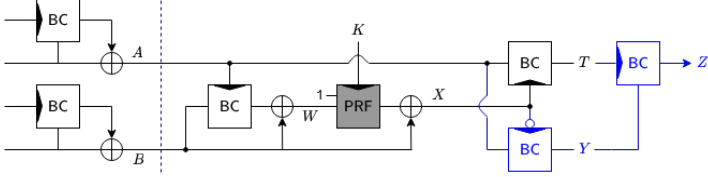
Figure 10: Our tag generation function with the tag comparison.